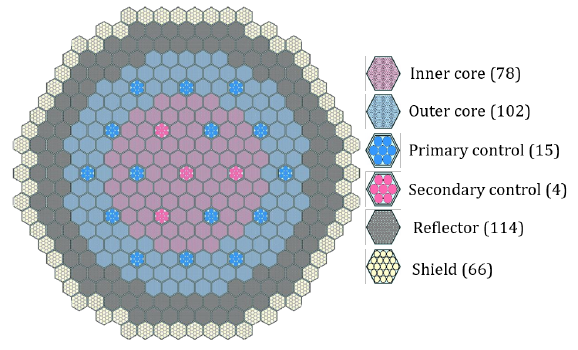
Figure 1. Radial Layout of Metallic Core